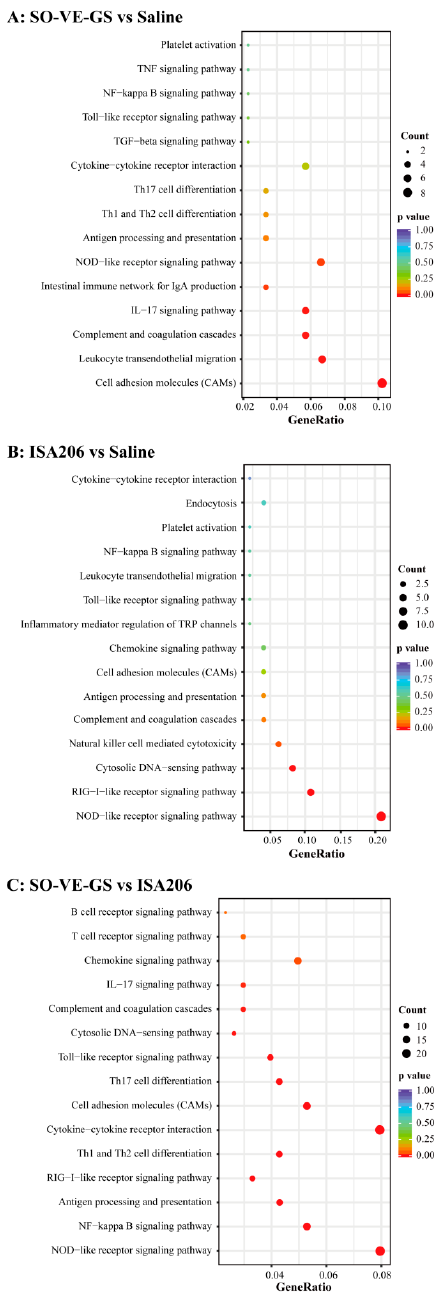
Figure 9. Enrichment of KEGG pathways analysis. DEGs of ( A ) SO-VE-GS vs Saline, ( B ) ISA206 vs Saline, and ( C ) SO-VE-GS vs ISA206 were used for KEGG pathway analysis. The X-axis represents the value of the gene ration. The Y-axis represents the enrichment term of the pathway. The size of the dot represents the number of DEGs. The color represents an adjusted P value.